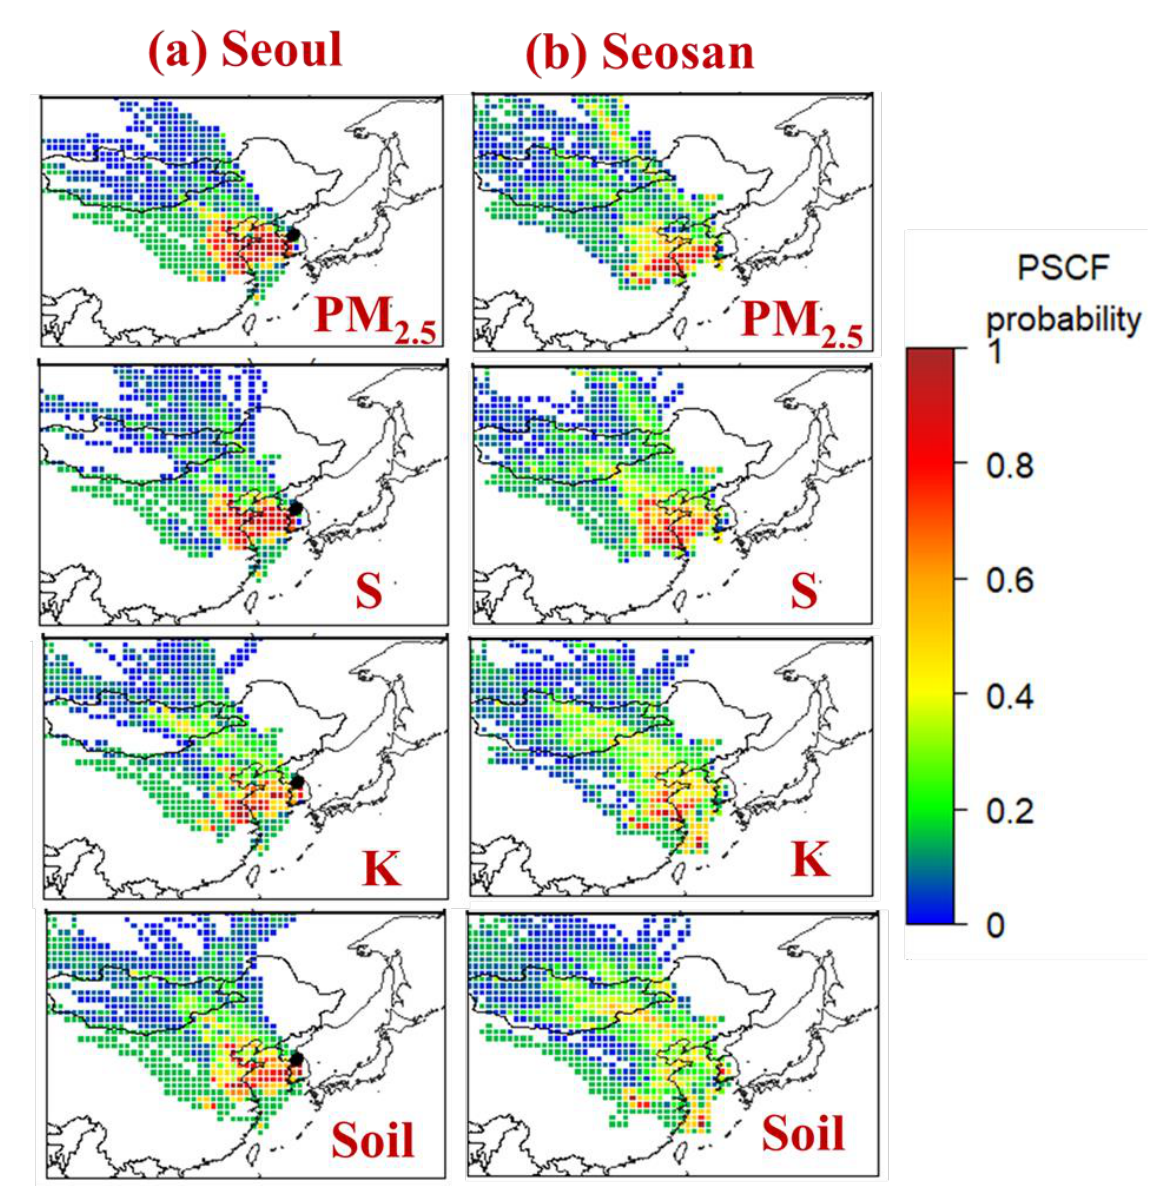
Figure 3. Potential source contribution function values for PM 2.5 , S, K, and soil throughout the study period in ( a ) Seoul and ( b ) Seosan, South Korea, during